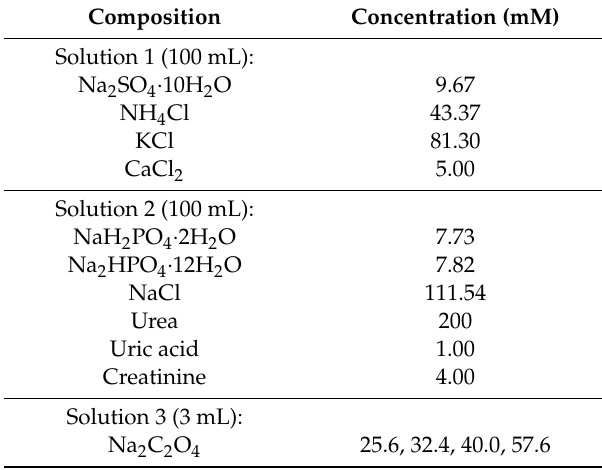
Table 1. The initial concentrations of all the components in solution 1, solution 2 and solution 3, respectively, before mixing for the synthetic urine adopted in this